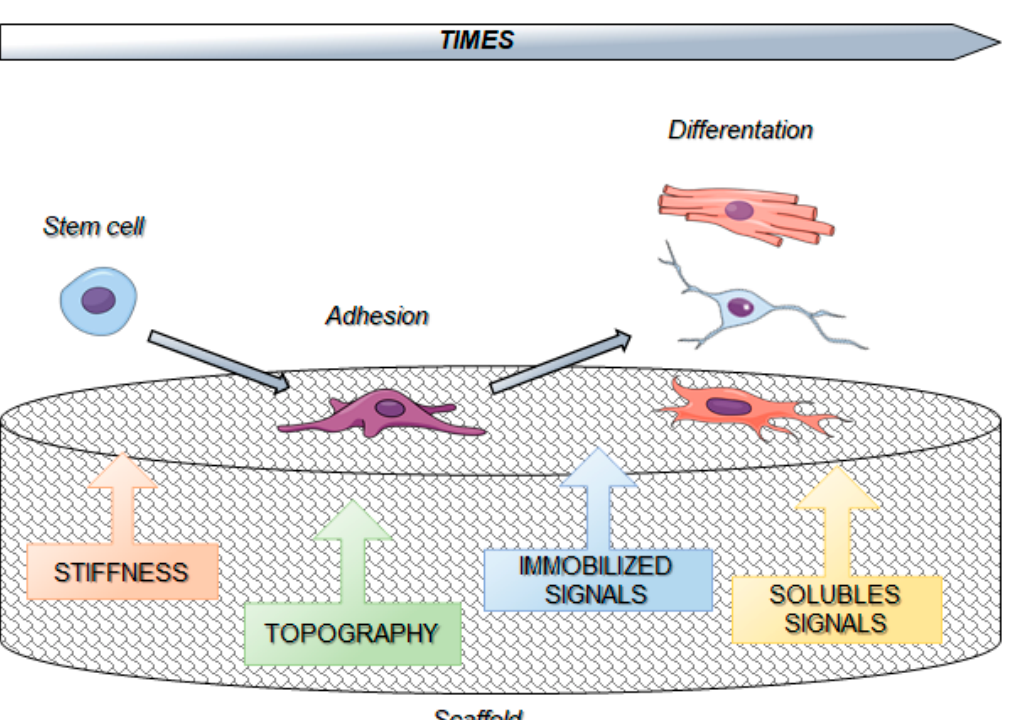
Figure 2. Biomaterial features affecting cell fate.